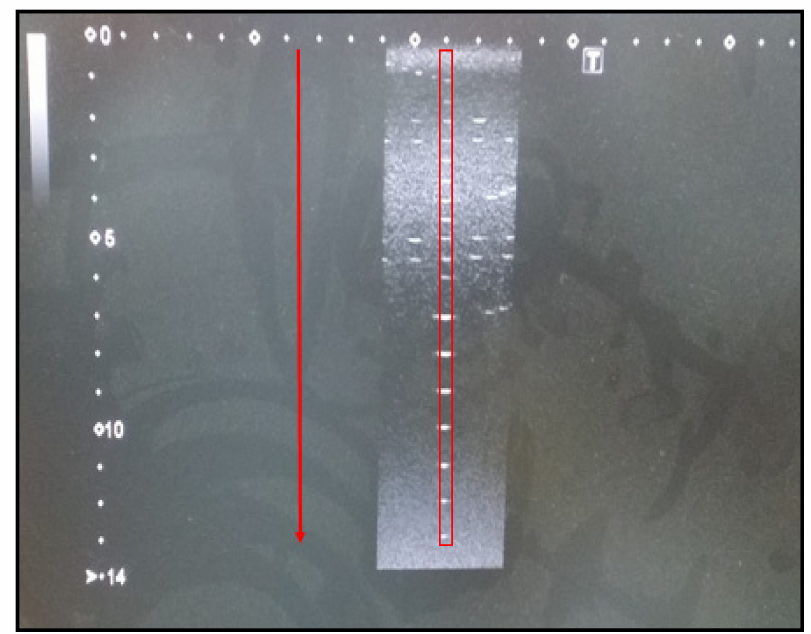
Figure 4. Maximum display